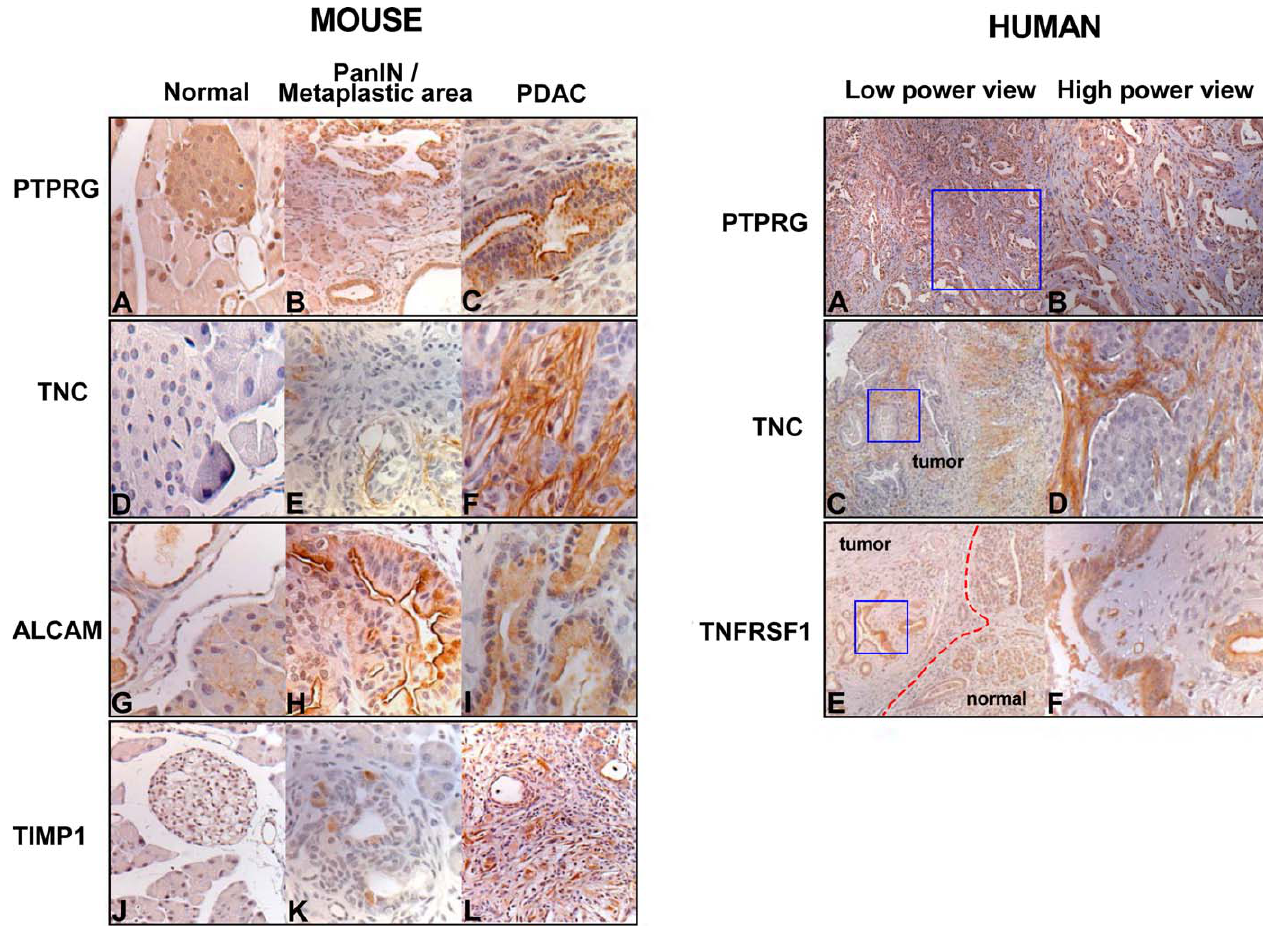
Figure 4. IHC Analysis of Candidate PDAC Biomarkers in Mouse and Human Tissue Mouse, left photomicrographs: PTPRG expression (A–C). Note islet staining in normal pancreas (A); membranous staining is seen in PanIN and PDAC epithelium (B and C). TNC expression (D–F). Note lack of staining in normal pancreatic tissue (D); strong expression is present in stroma of PanIN (E) and PDAC (F). ALCAM expression (G–I). Note membranous staining of the normal pancreatic acinar and ductal cells (G); increased staining is present in the PanIN epithelium (H) and PDAC cells (I). TIMP1 expression (J–L). Note lack of staining in normal pancreatic tissue (J); staining is observed in association with acinar-ductal metaplasia (K) and both PDAC stromal and tumor cells (L). (A–C, J–L, magnification 200 3 ; D–I, magnification 400 3 ). Human, right photomicrographs: PTPRG expression (A, B). Note membranous staining in PDAC epithelium and absence of staining in normal